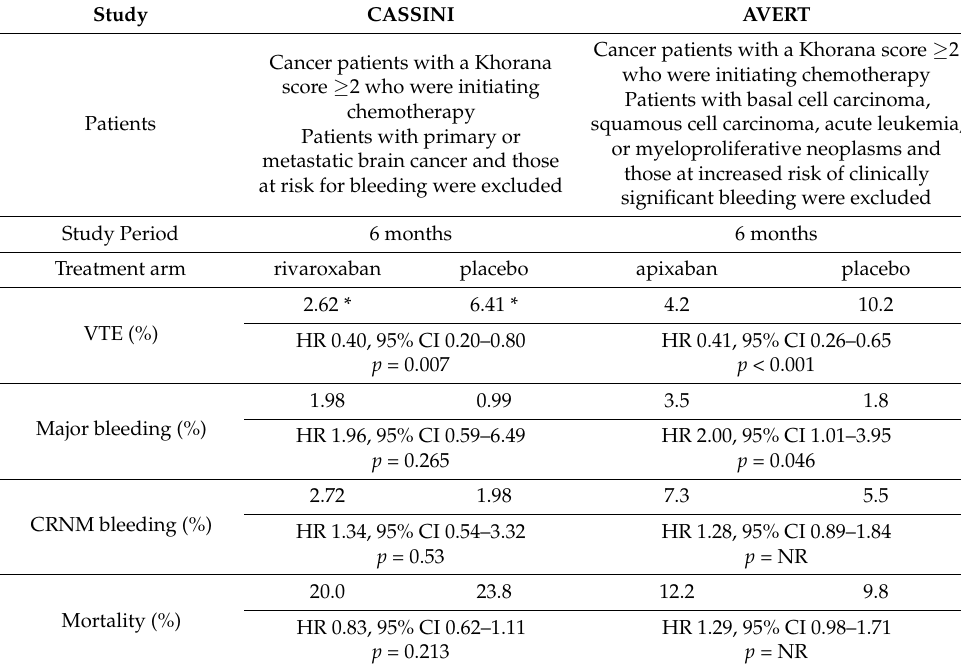
Table 2. DOAC vs. placebo for primary prophylaxis of VTE in Patients with cancer. Data from Prospective Randomized